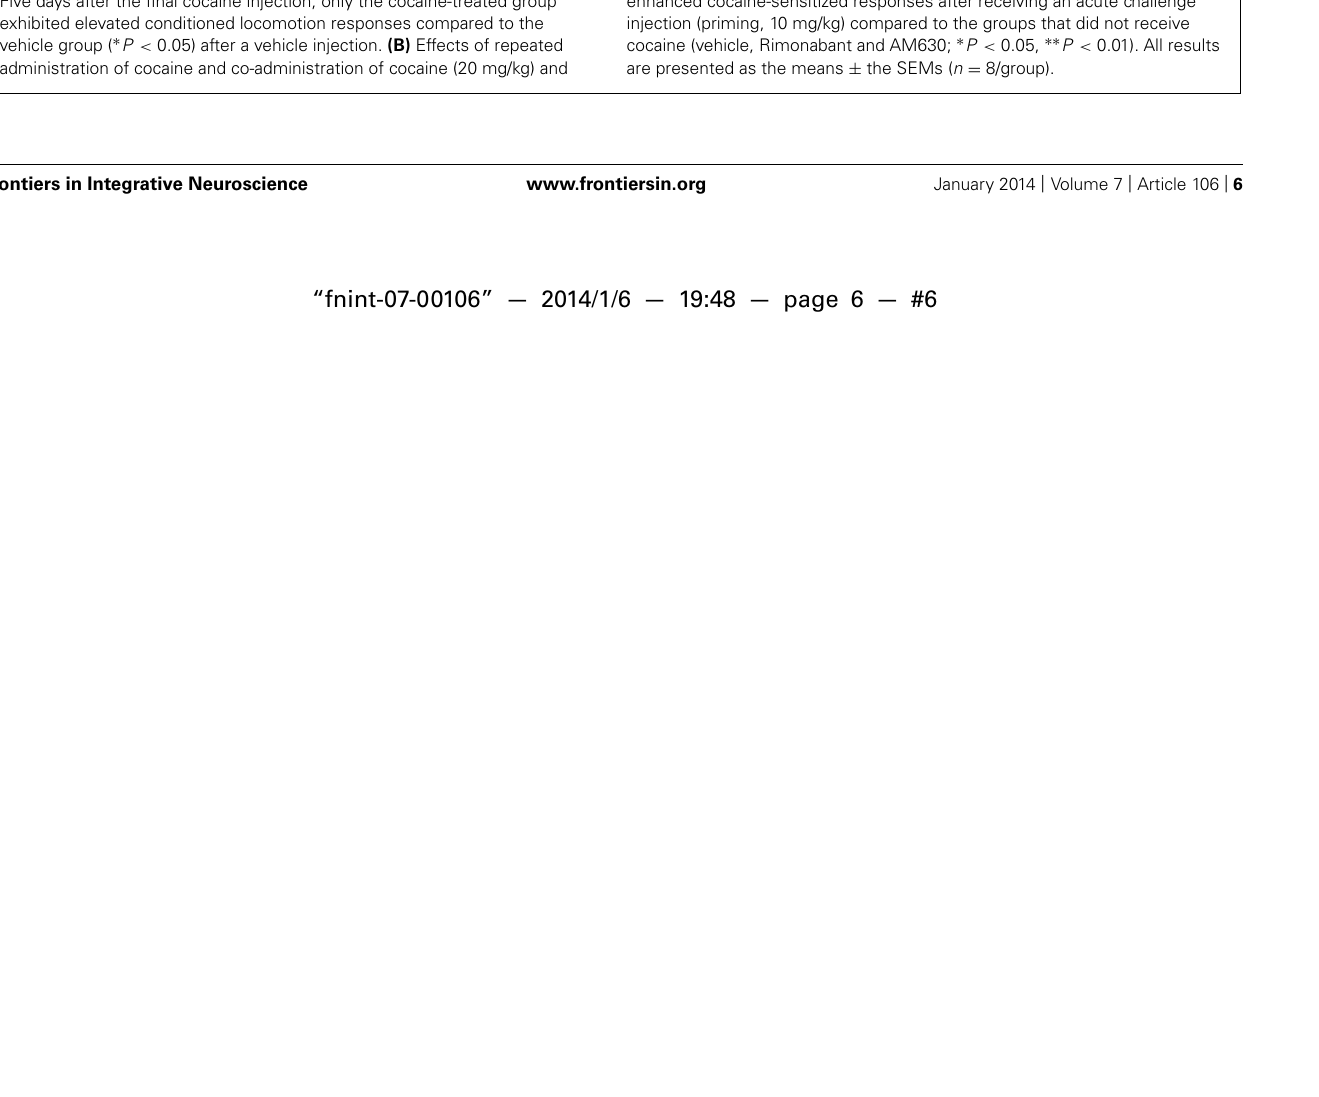
Rimonabant (3 mg/kg) or AM630 (3 mg/kg) on cocaine-induced sensitization measured in the OF test.The repeated cocaine-treated groups (cocaine, cocaine + Rimonabant and cocaine + AM630) exhibited significantly enhanced cocaine-sensitized responses after receiving an acute challenge injection (priming, 10 mg/kg) compared to the groups that did not receive cocaine (vehicle, Rimonabant and AM630; ∗ P < 0.05, ∗∗ P < 0.01). All results are presented as the means ± the SEMs ( n =